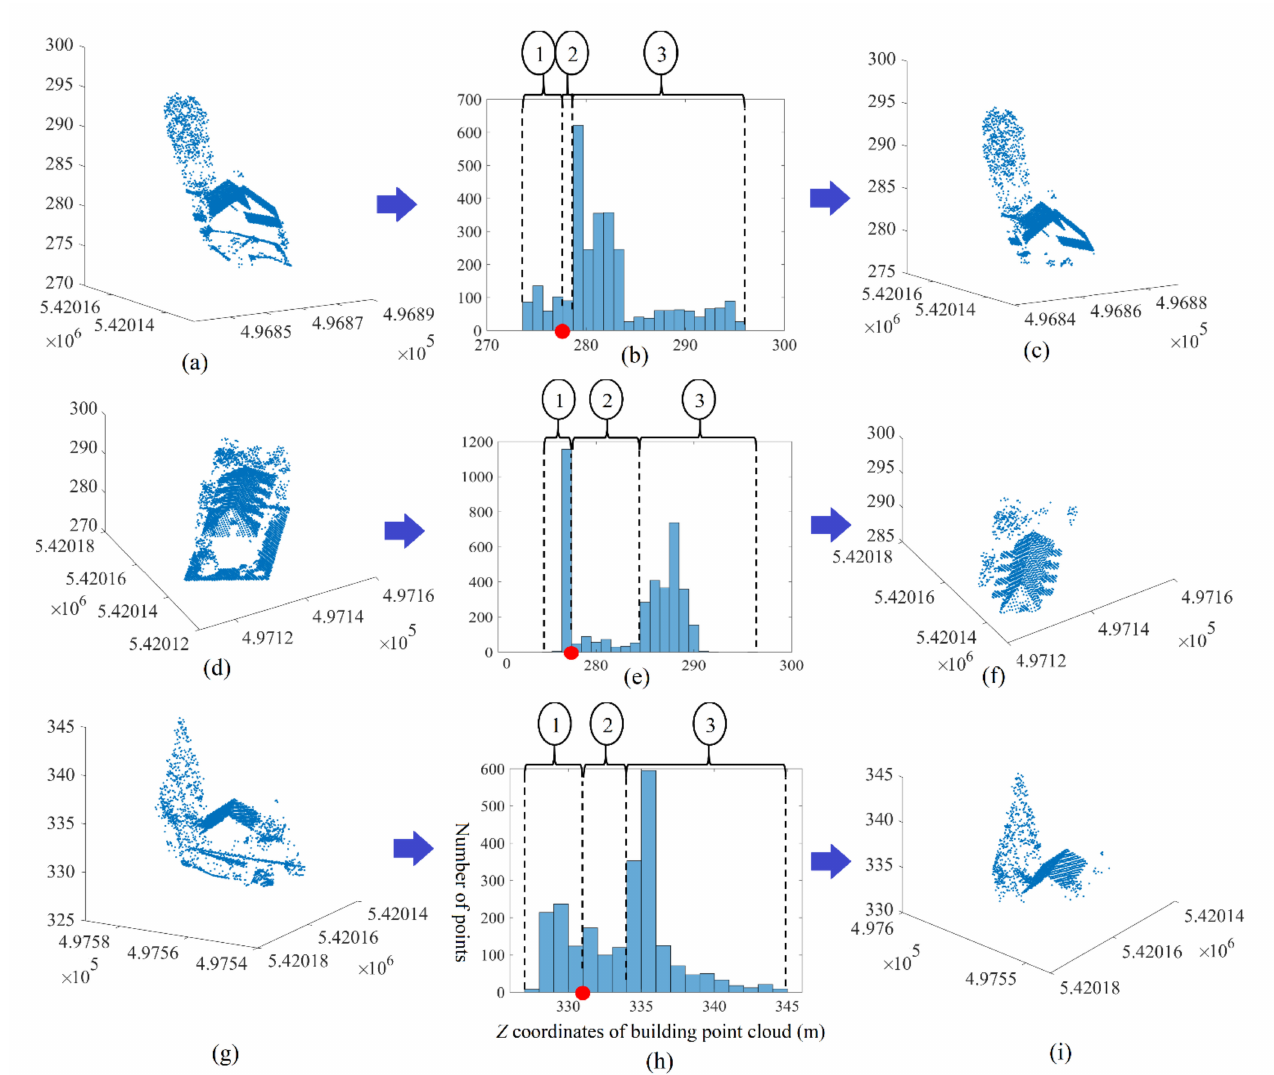
Figure 3. Results of filtering algorithm application in case of buildings which contain high trees that occlude the roof. ( a , d , g ) The original building point clouds; ( b , e , h ) histograms of building point clouds; ( c , f , i ) noisy roof point clouds; ( a – c ) building number 4; ( d – f ) building number 5; ( g – i ) building number 6; The red dots in ( b , e , h ) are the PSTF; “1,2,3” in circles in ( b , e , h ) are building section